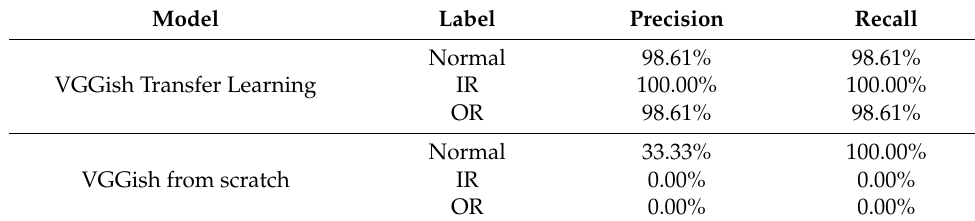
Table 8. Precision and recall of the diagnosis